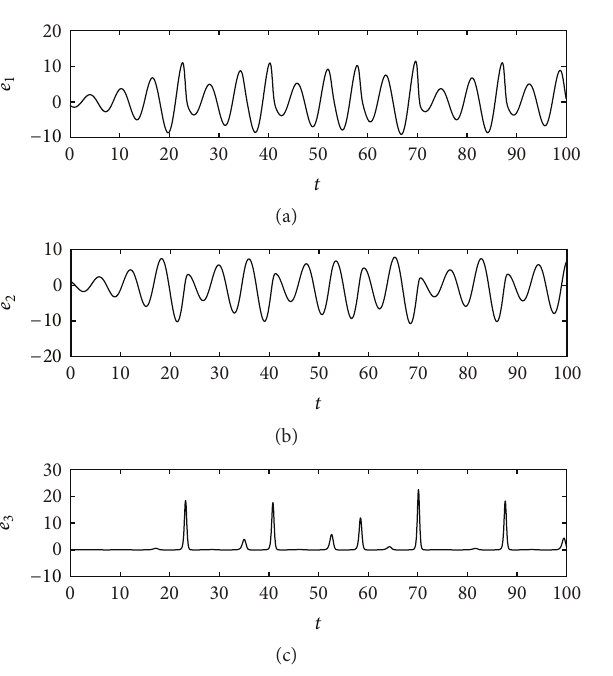
Figure 2: Time evolution of R¨ossler system. Figure 3: Time evolution of the synchronization errors of R¨ossler system with the gain matrix and nonlinear